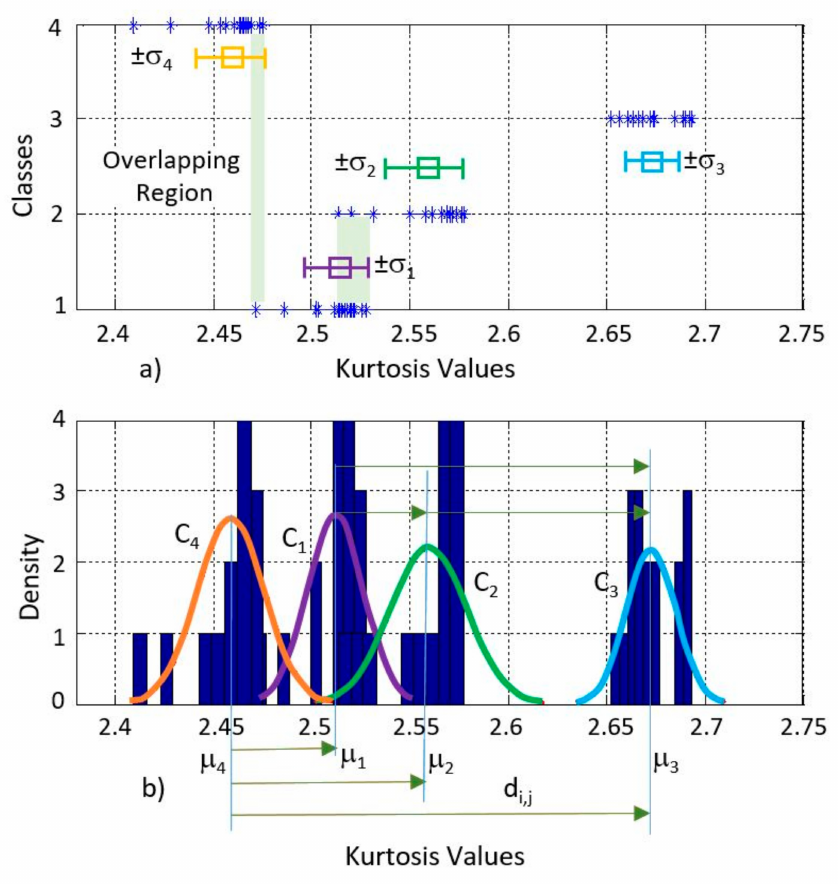
Figure 7. ( a ) Feature distribution in di ff erent classes and ( b ) distance between groups based on the mean